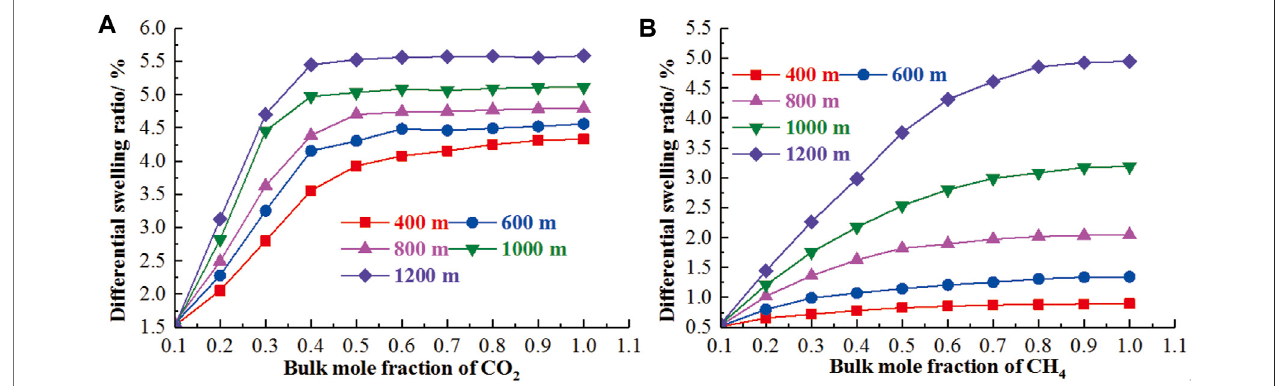
FIGURE 10 | The variations of the differential swelling of the n CO 2 + m CH 4 and the n N 2 + m CH 4 systems in geological conditions (Chen et al., 2021).